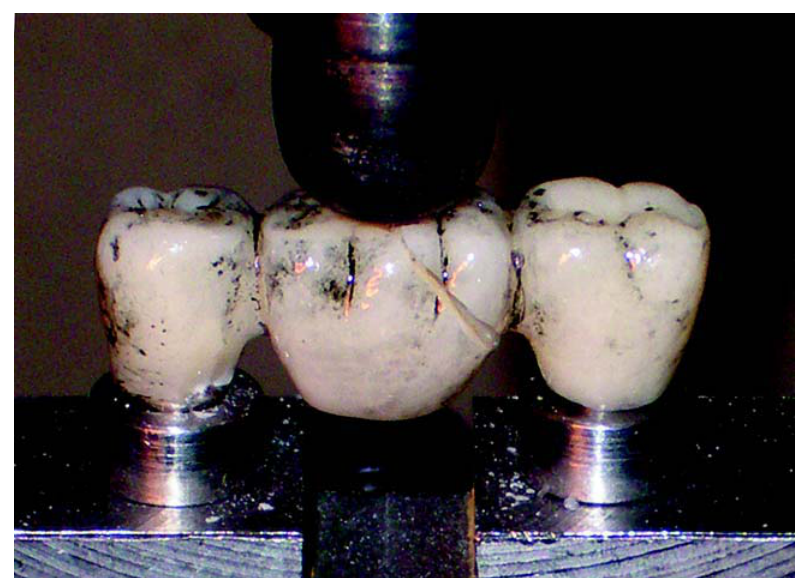
FIGURE 3- Example of a fractured fixed partial